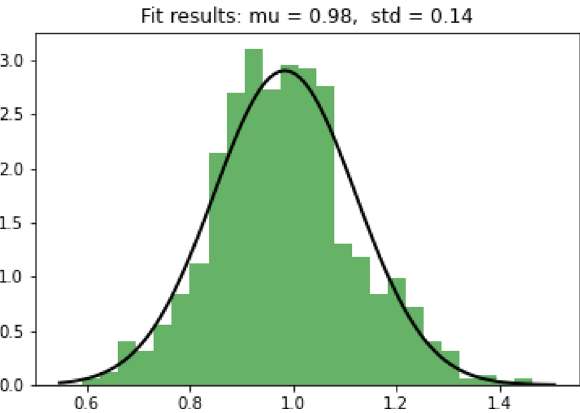
Figure 2. Histogram of RIs.